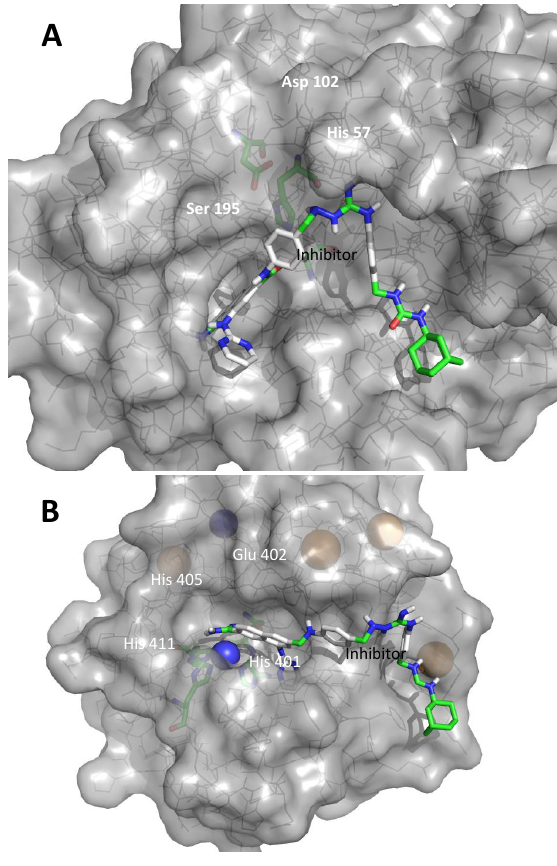
Fig 2. Best inhibitor of urokinase and MMP-9 (UI1xAGB). A: uroki- nase surface amino acids of catalytic triad (His57, Asp 102 and Ser 195) are shown as sticks model and colored: carbon i green, oxygen in red, nitrogen in blue, surface of uPA is shown in semitransparent gray. B: the catalytic center of MMP-9 is composed of the active- site zinc ion (shown as blue sphere), co-ordinated by three histidine residues (401, 405 and 411) and the essential glutamic acid residue (402) shown as a stick model colored: carbon - green, oxygen - red, nitrogen - blue), surface of uPA is shown in semitransparent